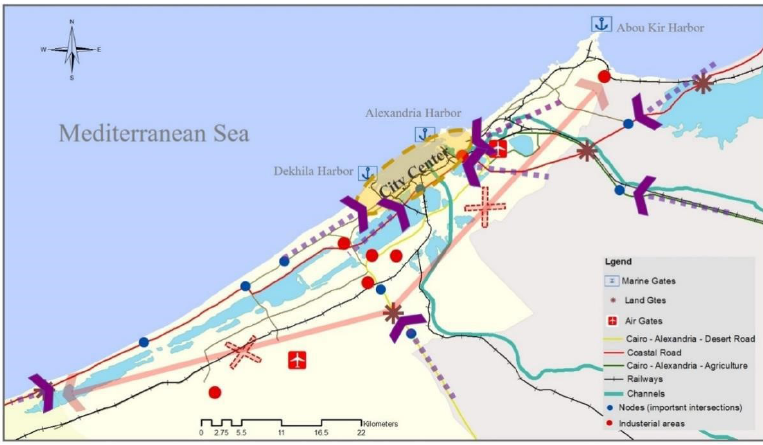
Figure 3. the transportation and connectivity problems in